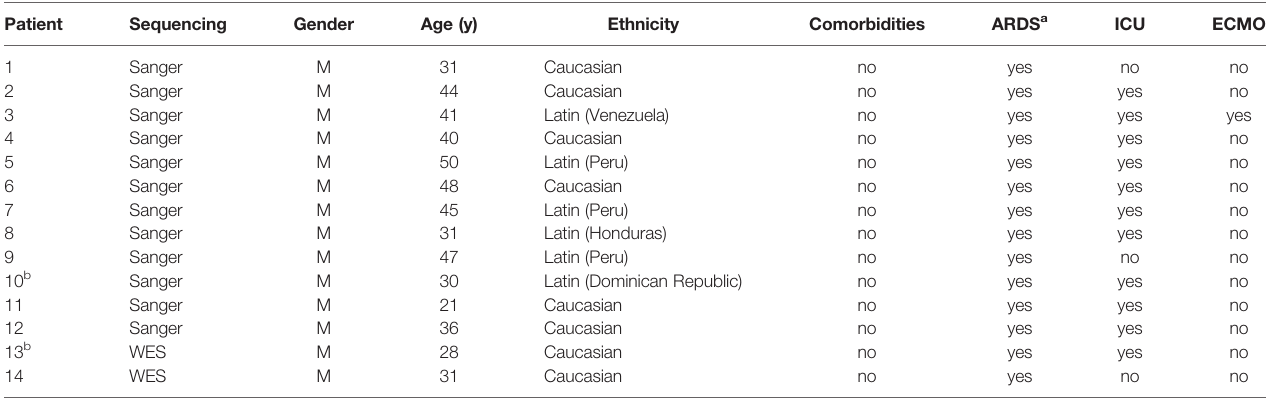
TABLE 1 | Demographic and clinical fi ndings of investigated patients.